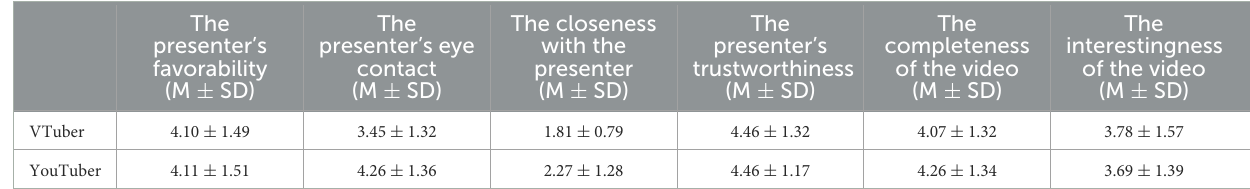
TABLE 4 Ratings for overall